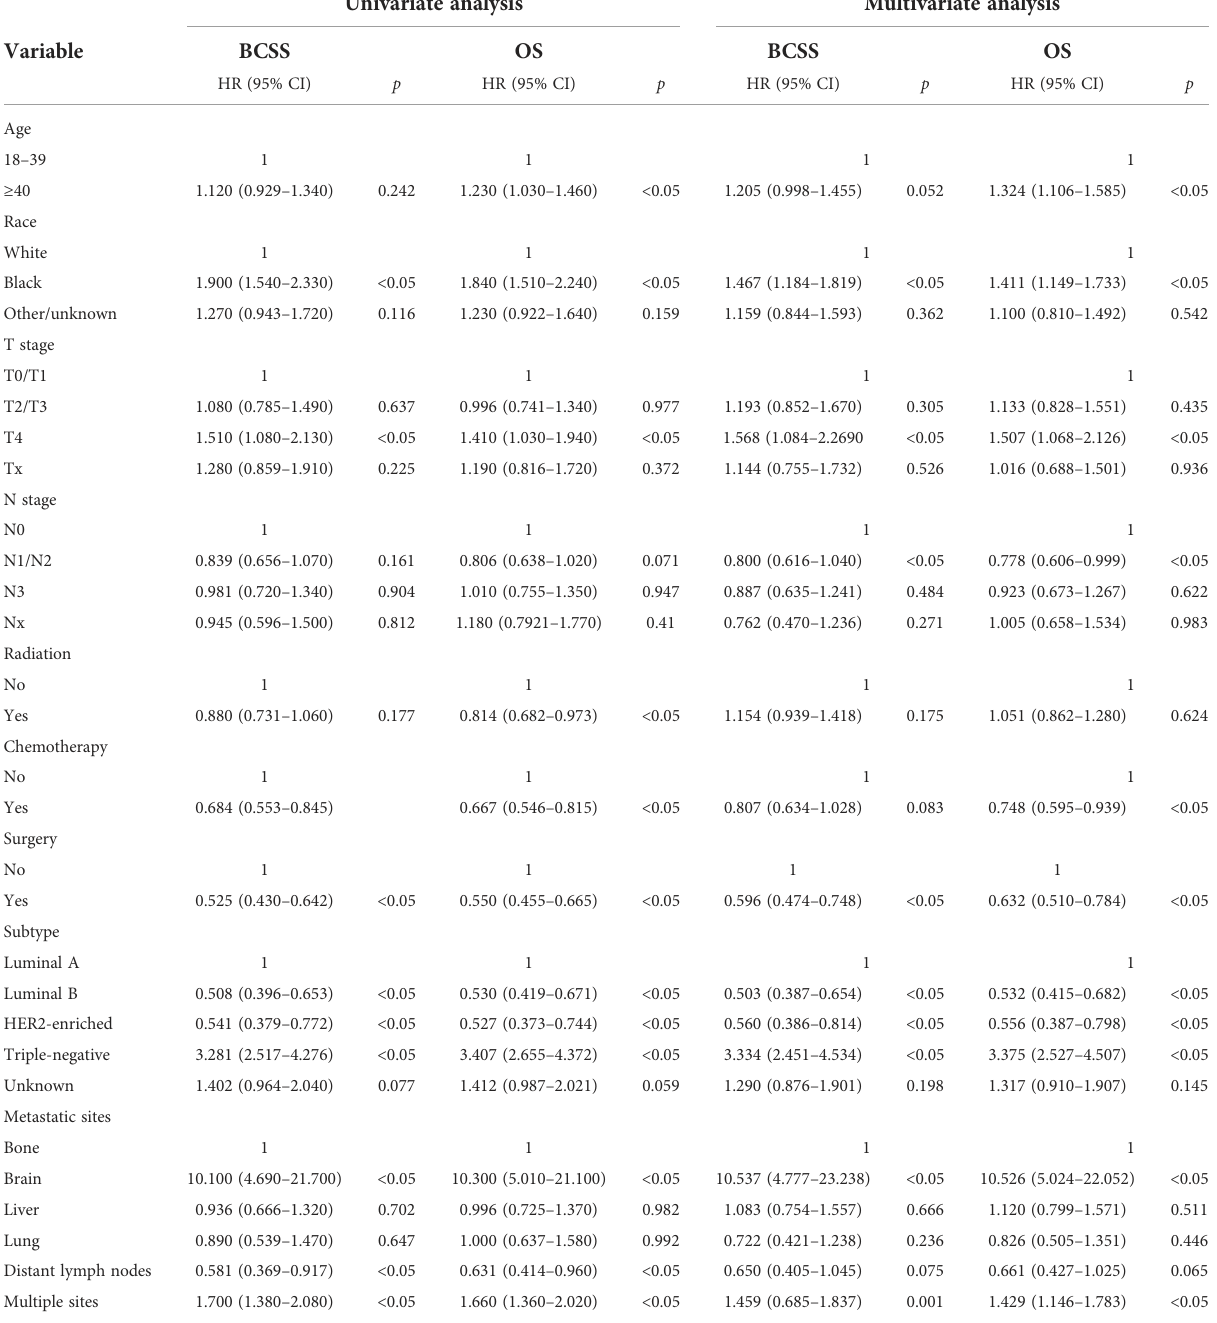
TABLE 3 Univariate and multivariate analyses of the OS and breast cancer-speci fi c survival BCSS of the study population after PSM. Univariate analysis Multivariate